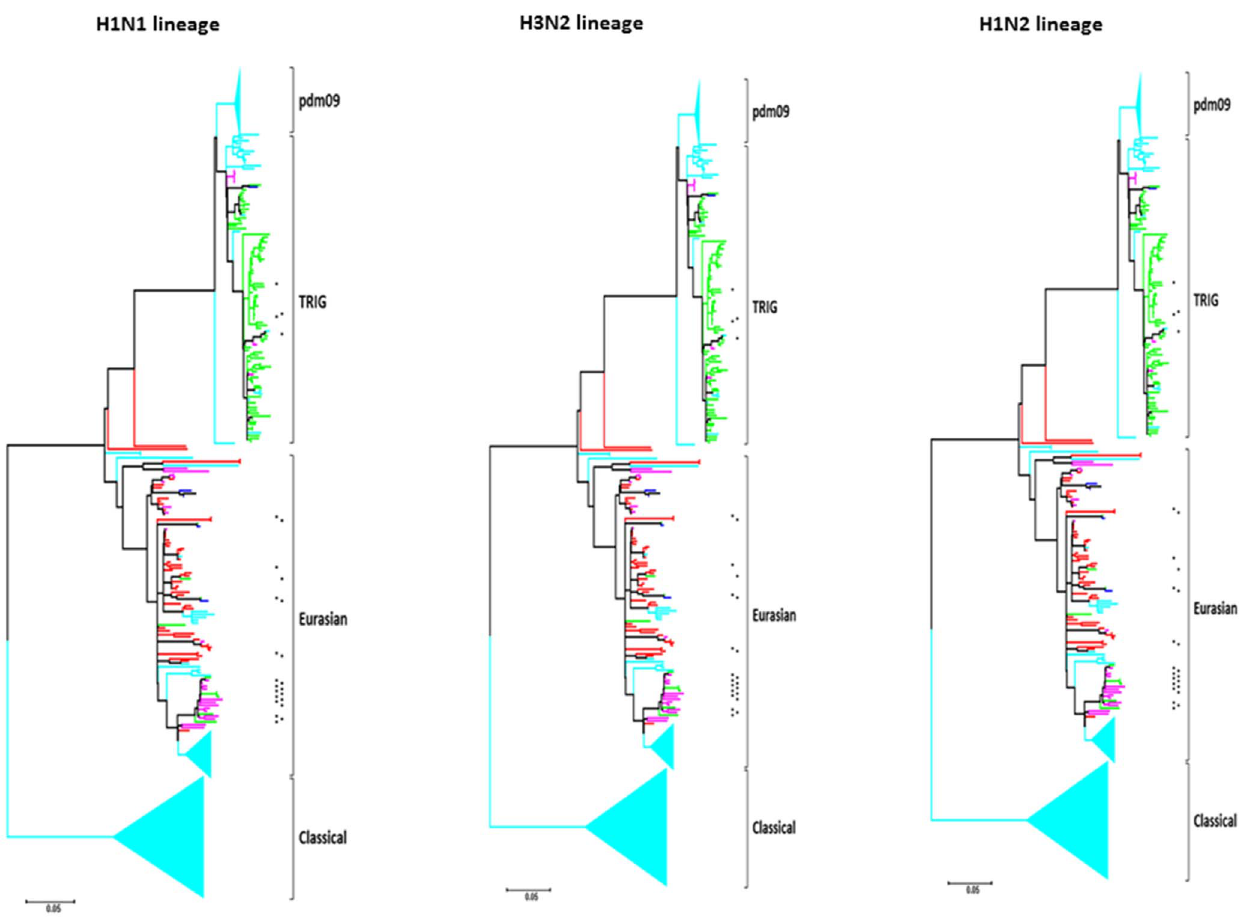
Figure 2. Phylogeny overview of swine influenza A PB1 gene. Phylogenetic analysis for 789 H1N1, 529 H3N2, and 329 H1N2 SIVs are shown. 1, 2, 3, and 4 inflammatory residues are indicated in blue, green, fuchsia, and red, respectively. The presence of a cytotoxic residue is indicated by an asterisk. Cyan indicates PB1-F2 proteins truncated before residue 62. More detail, including strain names and bootstrap values, is shown in Figure S1.